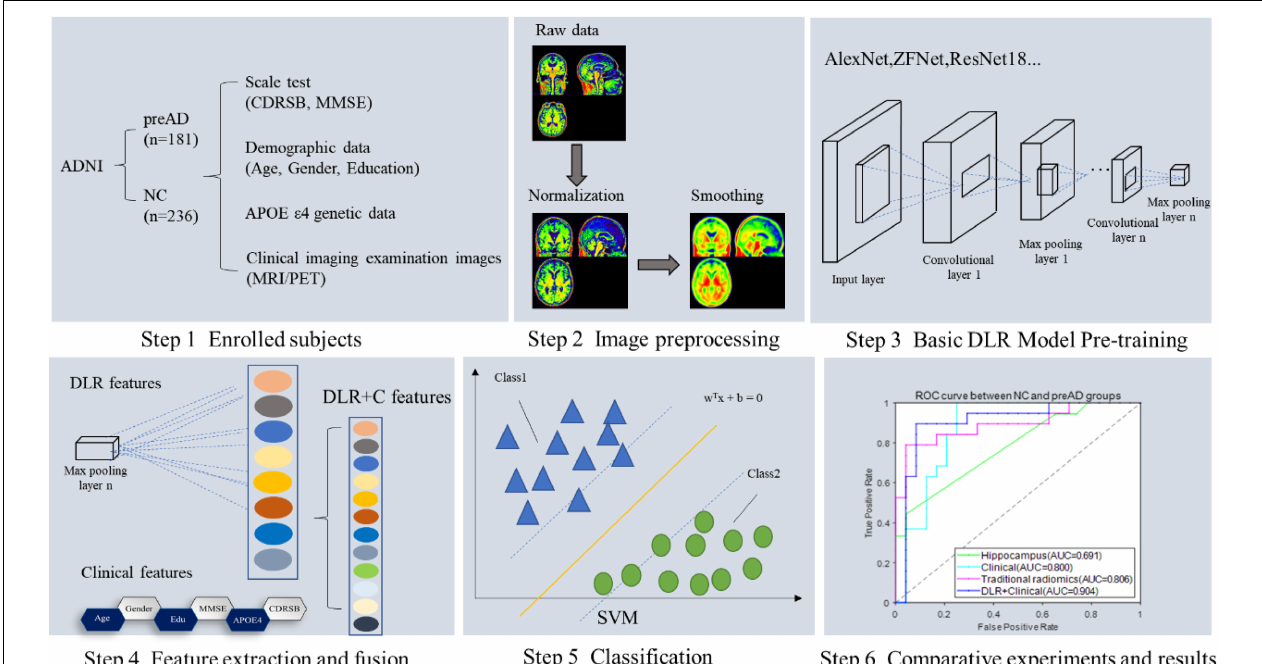
FIGURE 1 | The framework of this